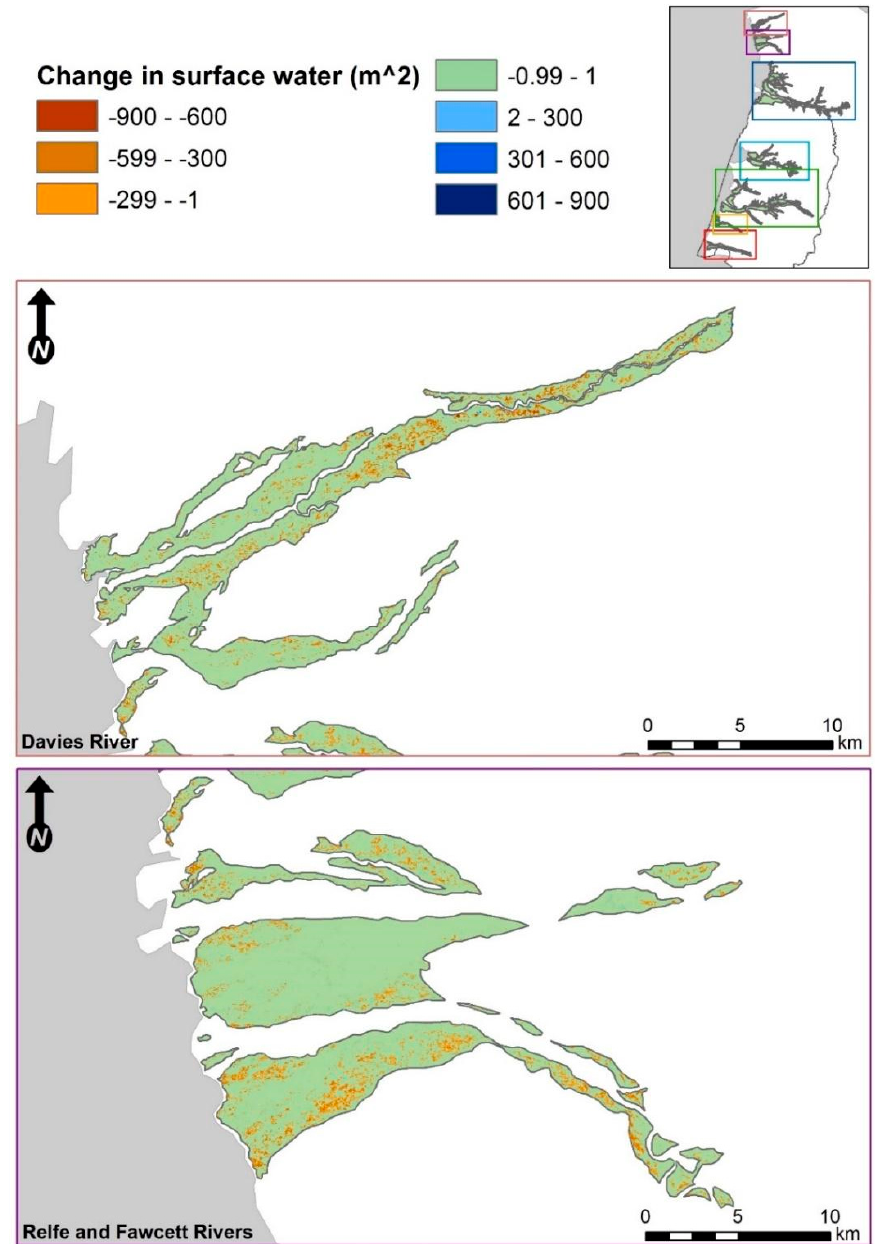
Figure A1. Sub-pixel water fraction trend surfaces of the Davies, Relfe, and Fawcett river valleys of western Banks Island, between 1985–2015.